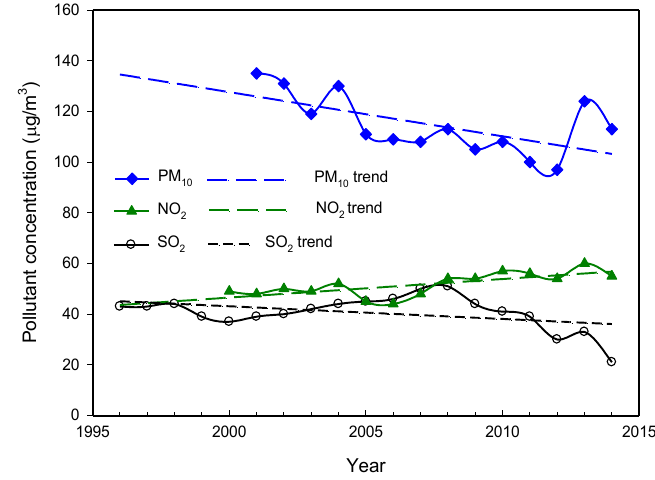
Figure 2. Annual mean concentrations of air pollutants in urban Wuhan.